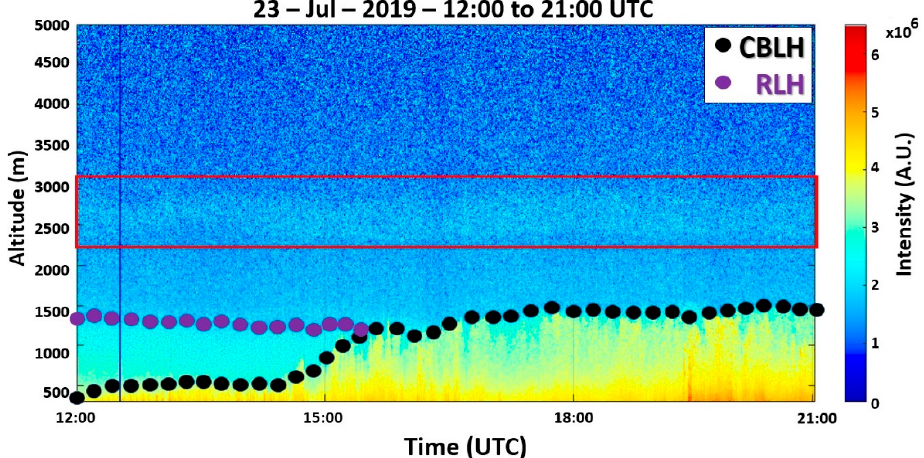
Figure 6. RCS 532 profiles from 12:00 to 21:00 UTC on 23 July 2019. The black dots represent the CBLH, and the purple dots represent the RLH. The color bar represents the intensity of the RCS 532 . Sensors 2020 , 20 , x FOR PEER REVIEW